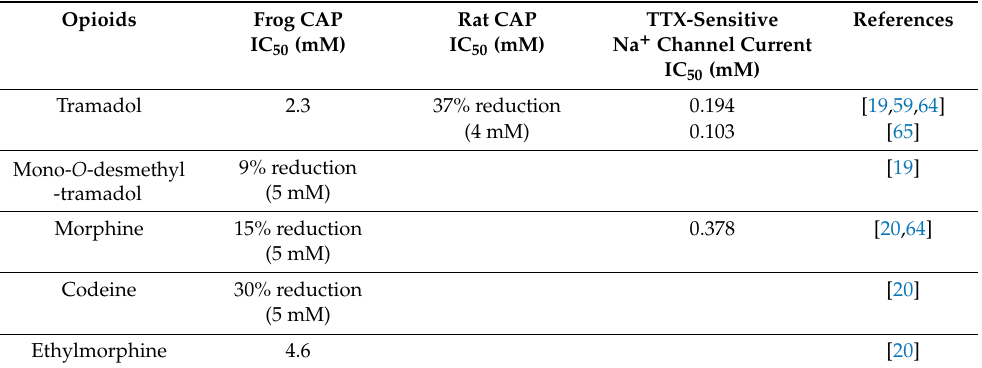
Table 1. Comparison of IC 50 values in inhibiting frog or rat sciatic nerve fast-conducting CAPs and TTX-sensitive Na + channels among